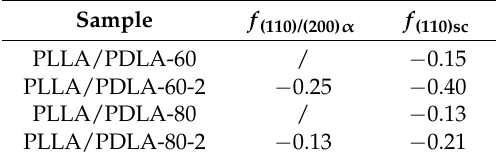
Table 3. The orientation factor of PLLA/PDLA fibers.